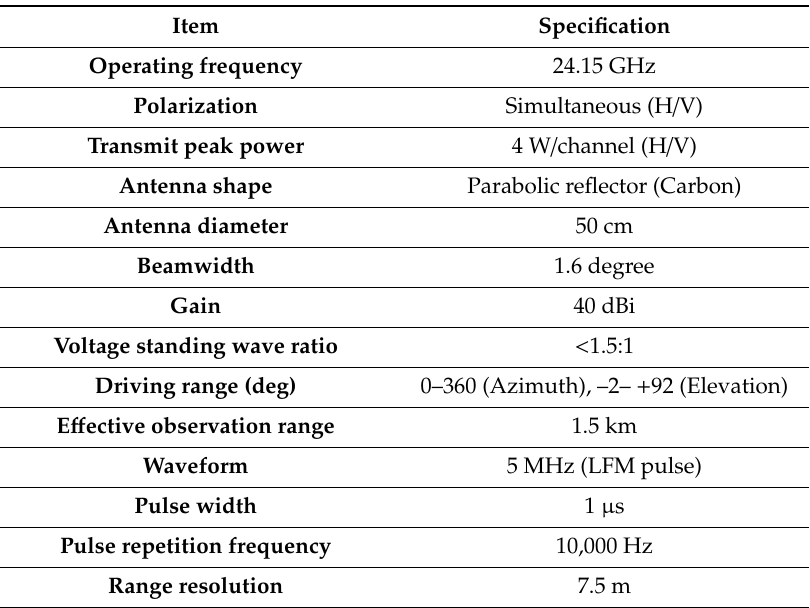
Figure 2. EWRG prototype block diagram. Table 1. Specifications of EWRG prototype.